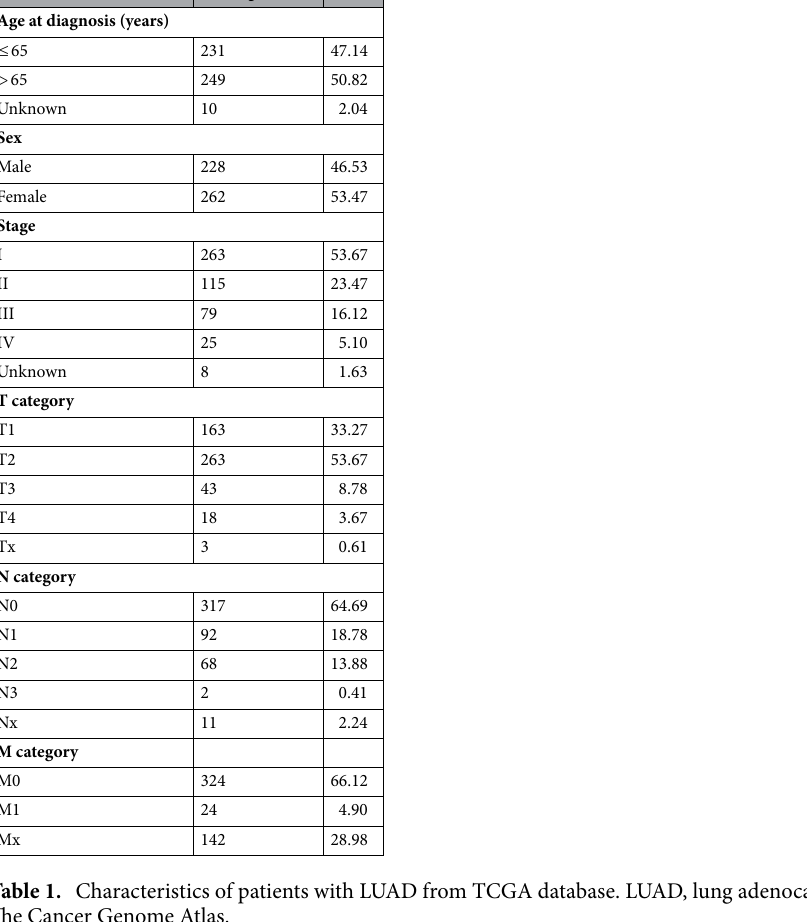
Table S1). Among them, 91 DEirlncRNAs were identified between LUAD and normal controls, of which 73 DEirlncRNAs were upregulated and 18 DEirlncRNAs were downregulated (Fig. 1A and 1B and Supplementary